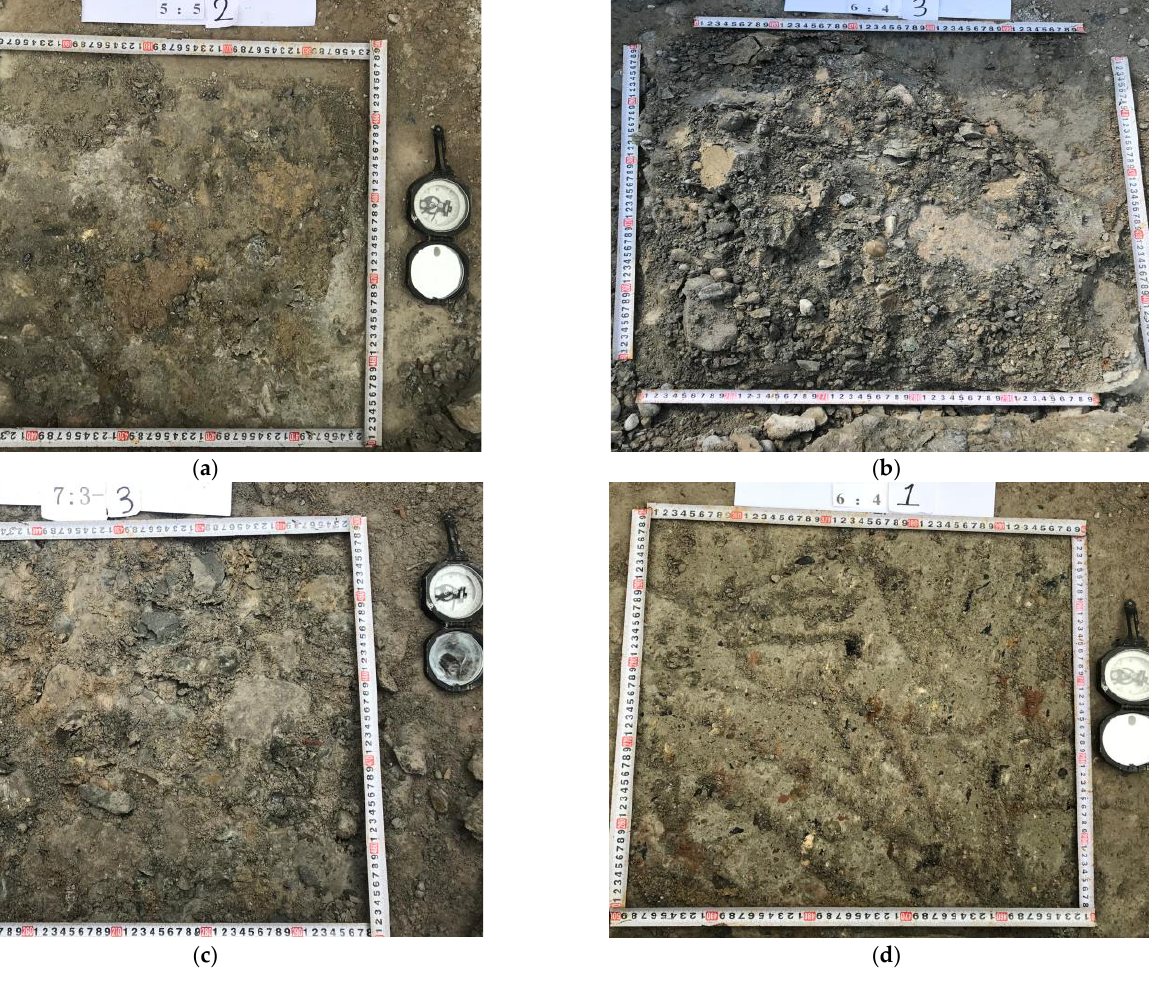
Figure 3. The typical failure of the shear piers: ( a ) soft sandstone contents of 50% between the bulk alone; ( b ) soft sandstone contents of 60% between the bulk alone; ( c ) soft sandstone contents of 70% between the bulk alone; and ( d ) soft sandstone contents of 60% between the bulk and the concrete interface. Table 2. Summary of the in situ direct shear test results of the test